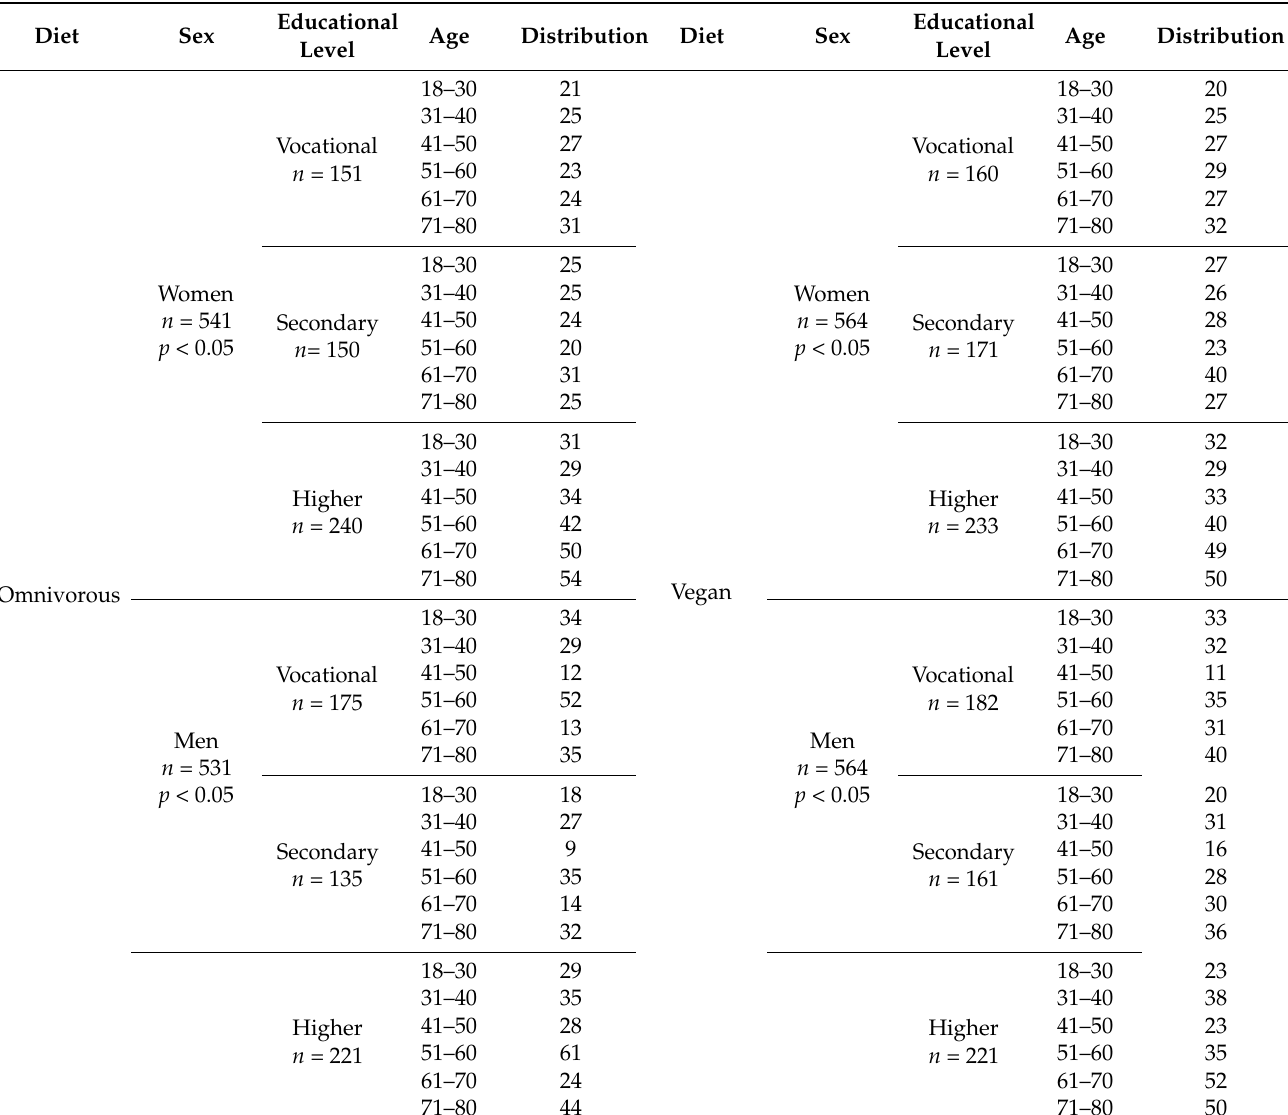
Table 1. Distribution [%] of respondents by age groups ( n =